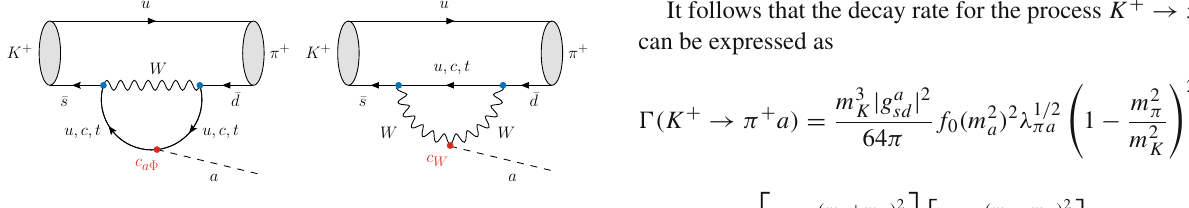
Fig. 1 Illustration of diagrams giving one-loop contributions to the process K + → π + a via the interactions defined in Eq. (3)